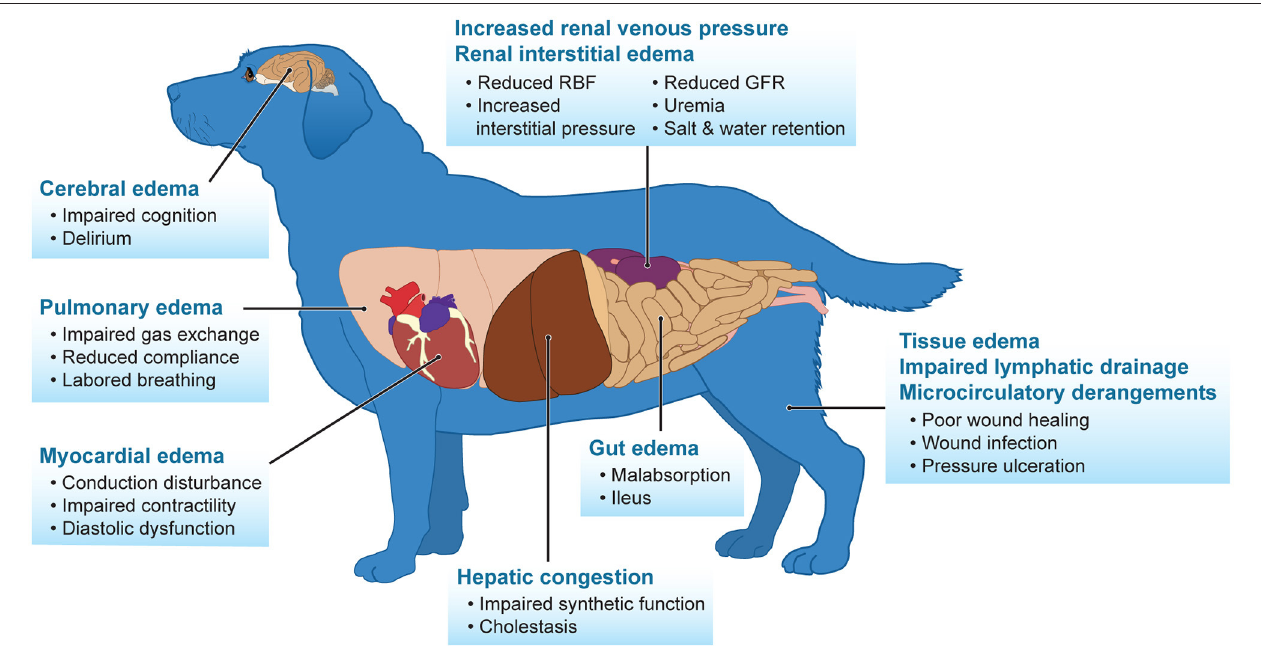
FIGURE 1 | Fluid overload adversely impacts many body systems. Adapted from Prowle et al.